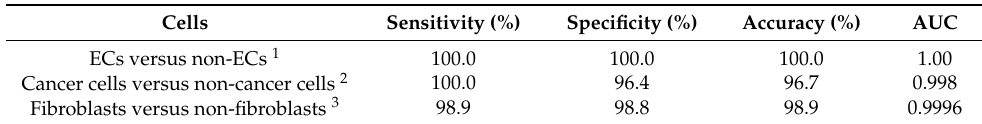
Table 1. The separation of different cell types based on CPF (proof-of-concept of high specificity of cell proteomic footprints at cell type